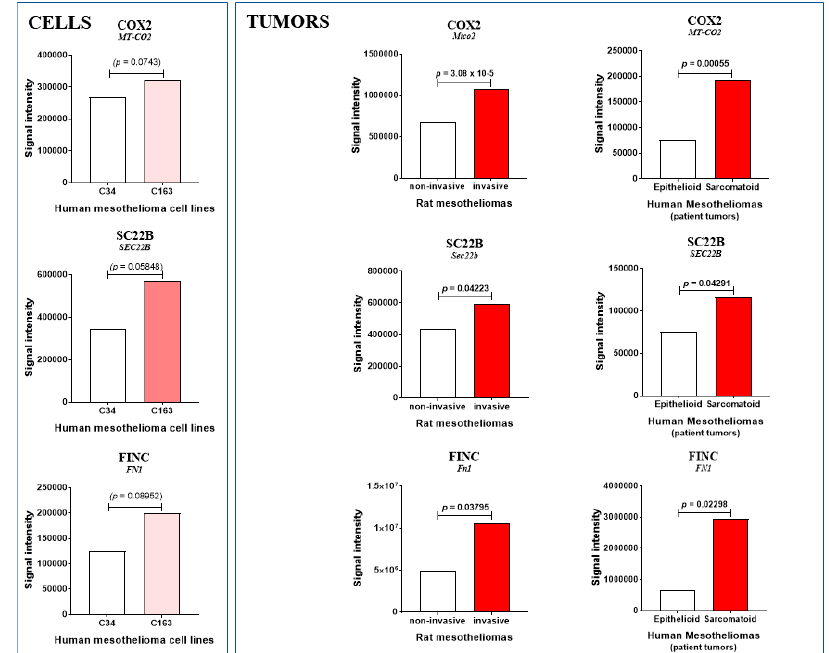
Figure 4. Main invasiveness biomarkers in human vs. rat MM, and cell lines. Proteins showing comparable abundance changes in MM from rat models and patients, and human mesothelioma cell lines. Increase and decrease are indicated by red and blue bars, respectively (with p values). Blank bars reflect the absence of significant changes ( p > 0.09), while light red bars indicate tendencies (0.05 < p < 0.09).